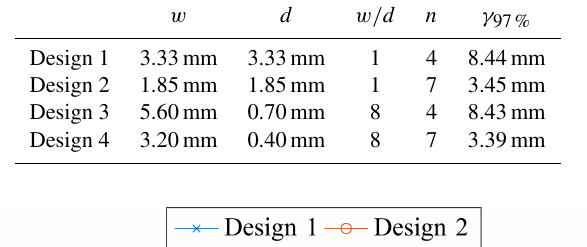
Table 1. Design specifications and evaluated penetration depth of the studied transducers.